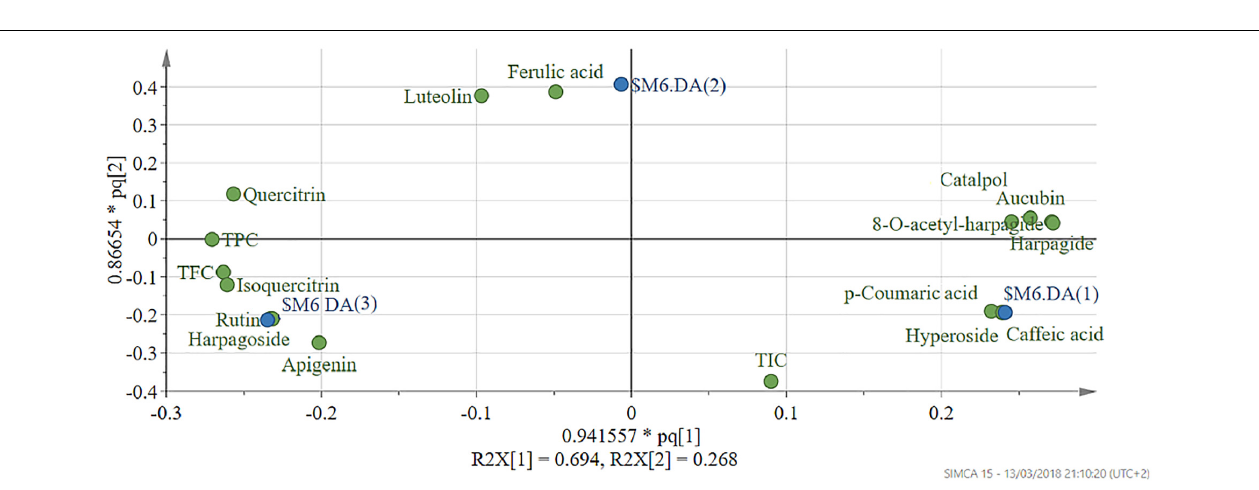
FIGURE 9 | Score scatter plot of the OPLS-DA model (R2Y-99.8% and Q2-99.5%) – t(1) – first predictive component vs. t(2) – second predictive component. Each observation is represented by a point in multidimensional space, differentially colored according to plant species. EEAG, A. genevensis ethanolic extract; EEAC, A. chamaepitys ethanolic extract; EEAL, A. laxmannii ethanolic extract. R2X-fraction of variability in X (physicochemical descriptors) explained by each component; R2Y-total variation of Y (class membership) explained by the model; Q2-predictive capacity.